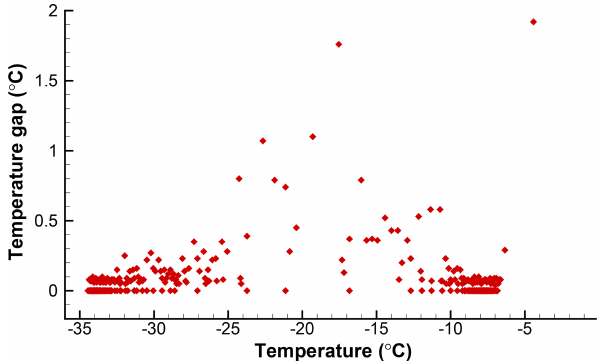
Figure 2. Plots of k(T ) for 0.2 and 0.5 ◦ C bin sizes for the data from Table 1. The right-hand scale is shifted down slightly to allow the two plots to be clearly seen. Zero values are indicated for the 0.5 ◦ C graph with values below the range covered by the ordinate. The ordinate values are for X = 1 of unspecified dimension, and thus the units are given as [ x − 1 ◦ C − 1